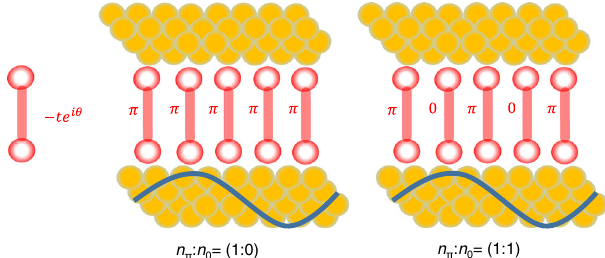
Fig. 5 | The minimal 2D model used for simulations. Schematic presentation of theminimalmodelusedinthecalculationsbasedontwo-sitemoleculesassumedto be coupled to both leads with the same coupling strength and with a phase- dependent (intra) coupling term between sites. The phase, θ , can be either π or 0. Thejunctionsusedinthecalculationscontained100molecules.Theimageshowsa junctionwithidenticalphase( π )forallmolecules(leftjunction)andajunctionwith a 1:1 phase-ratio (right